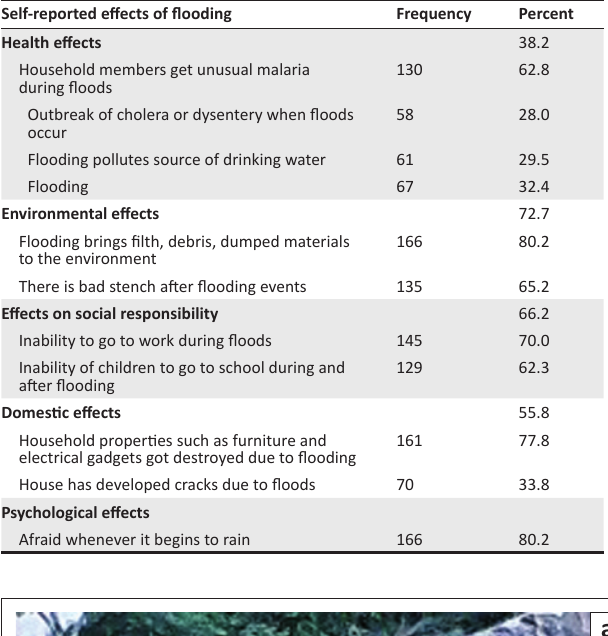
TABLE 2: Self-reported effects of flooding.